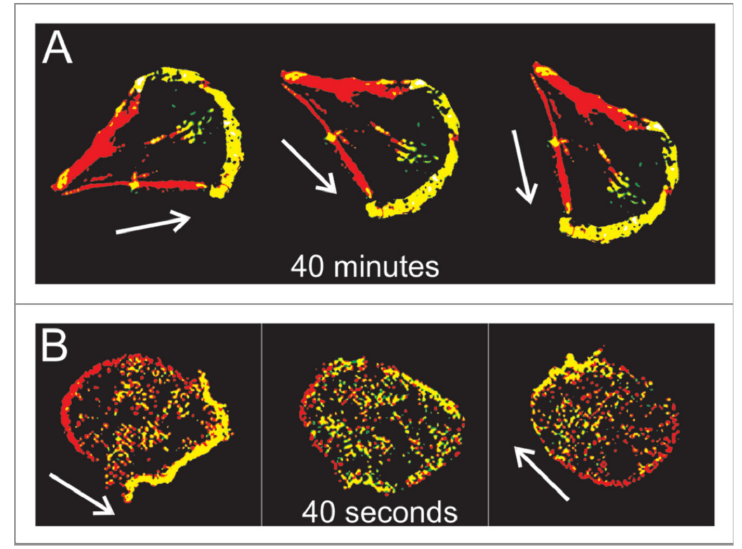
Figure 24. Re-orientation of fibroblasts ( A ) and Dicty ( B ). From Faix et al. [162]. Membrane tension plays a role in other contexts as